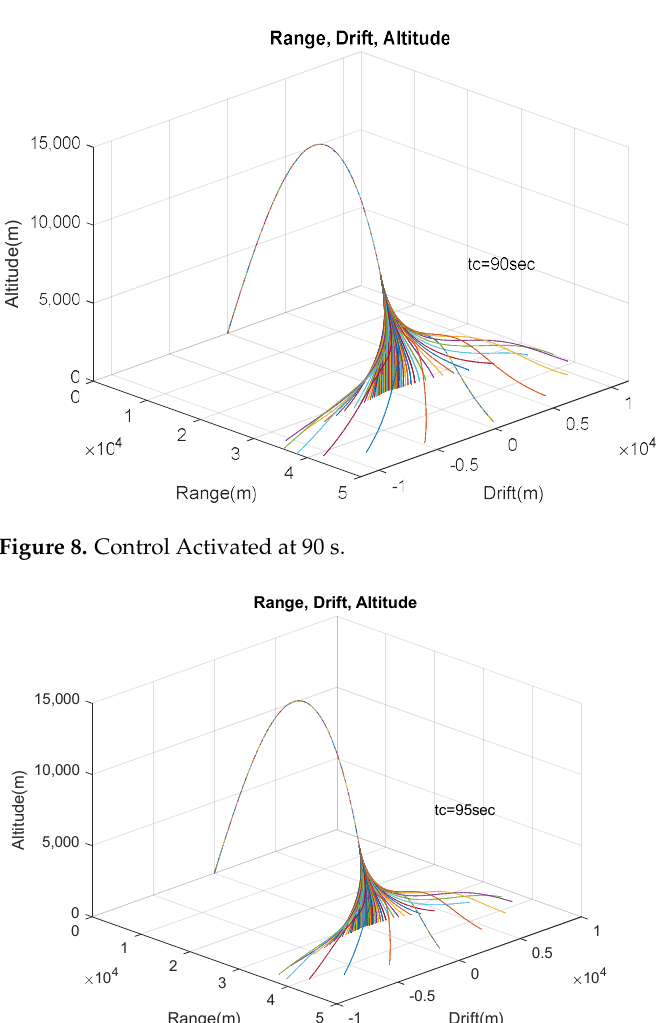
Figure 10. Control Activated at 100 s. Figure 11. Foot Print Area. The footprint area of rocket impact points decreases when control is activated later in the flight. The corresponding area plots of rocket impact points for various control ac- tivation times are shown in Figure 11. This area plot is necessary for analyzing and calcu- lating the swerve response of the projectile when control is activated at different intervals of flight.